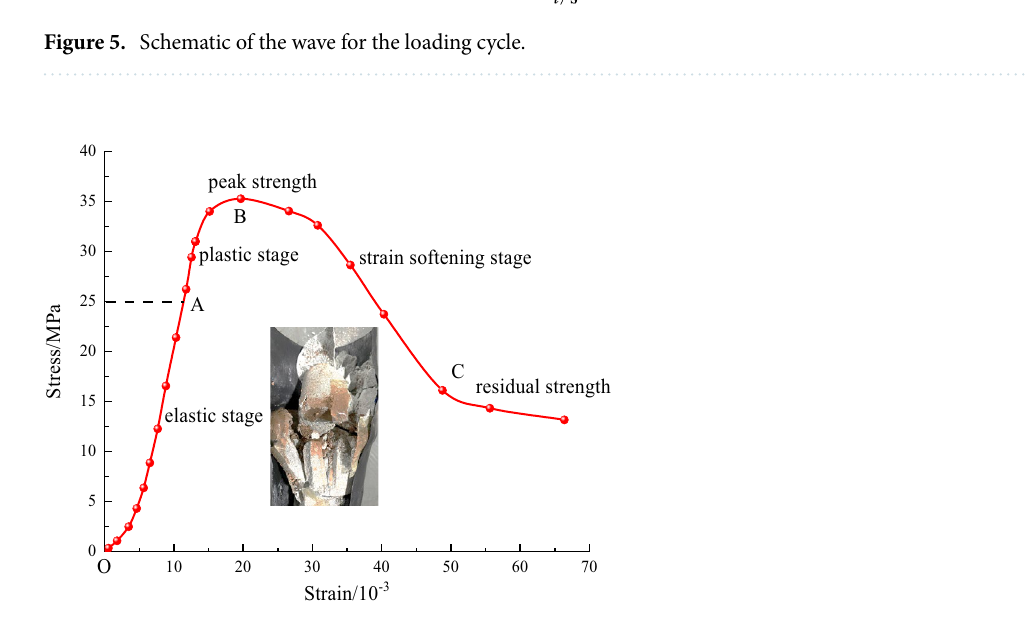
Figure 6. Stress ‒ strain curves under uniaxial